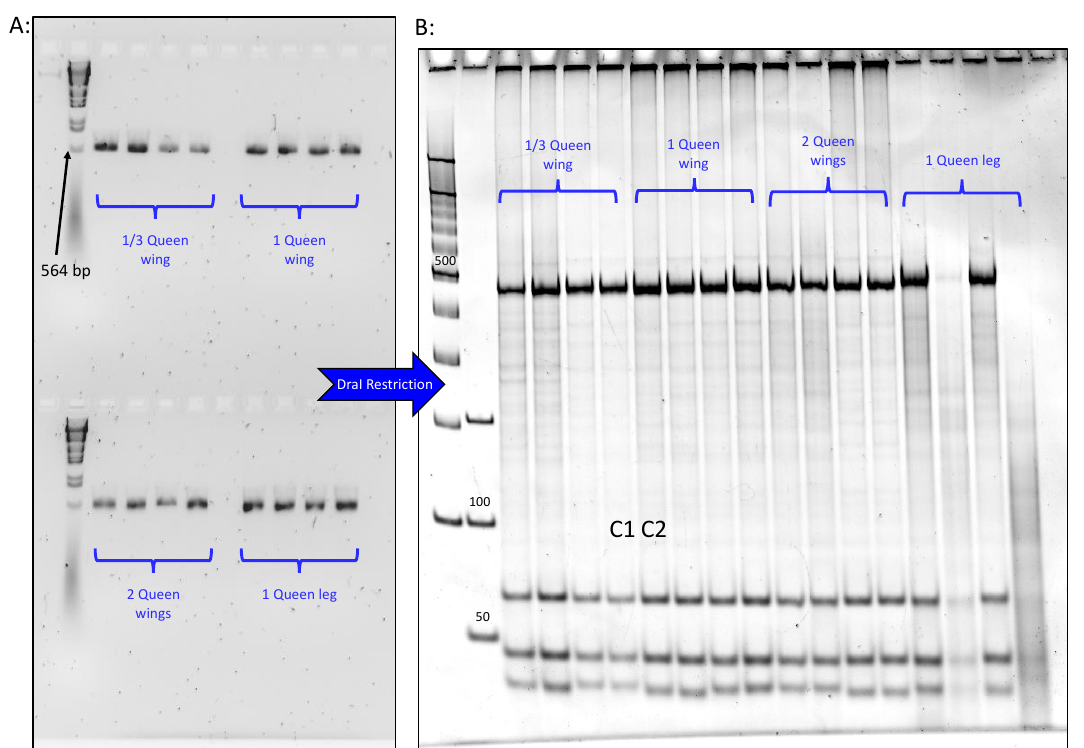
Figure 2. Results of the mtDNA genetic analysis conducted on queen wing and leg tissues. ( A ): PCR amplificons of the intergenic COI-COII region on 1.5% agarose gel, ladder is Lambda DNA/HindIII. ( B ): DraI restriction polymorphisms of the amplified intergenic region COI-COII revealed on 7.5% polyacrylamide gel. Queens exhibited both C1 and C2 haplotypes characterizing both honey bee subspecies; ligustica and carnica , respectively.